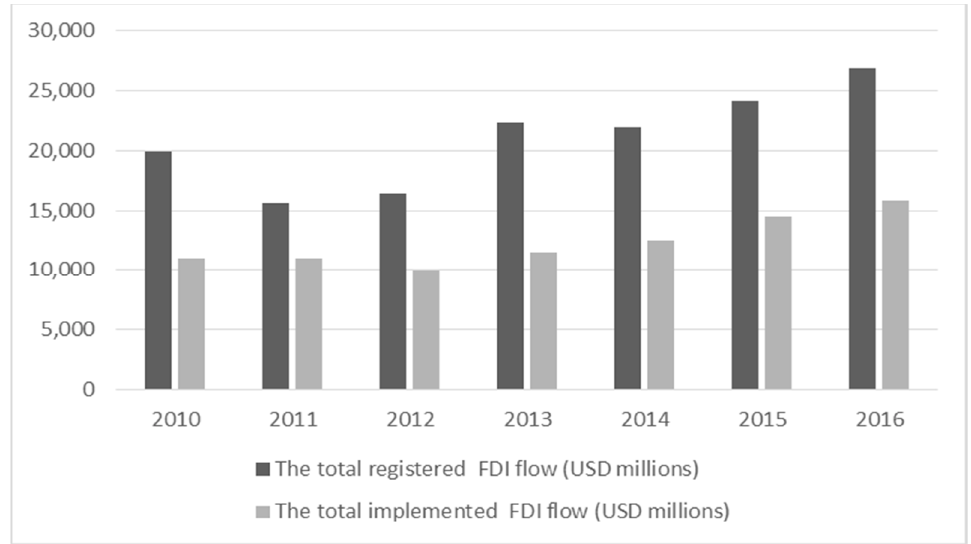
Figure 1. Foreign direct investment flow in Vietnam, from 2010 to 2016. Source: General Statistics Office of Vietnam.